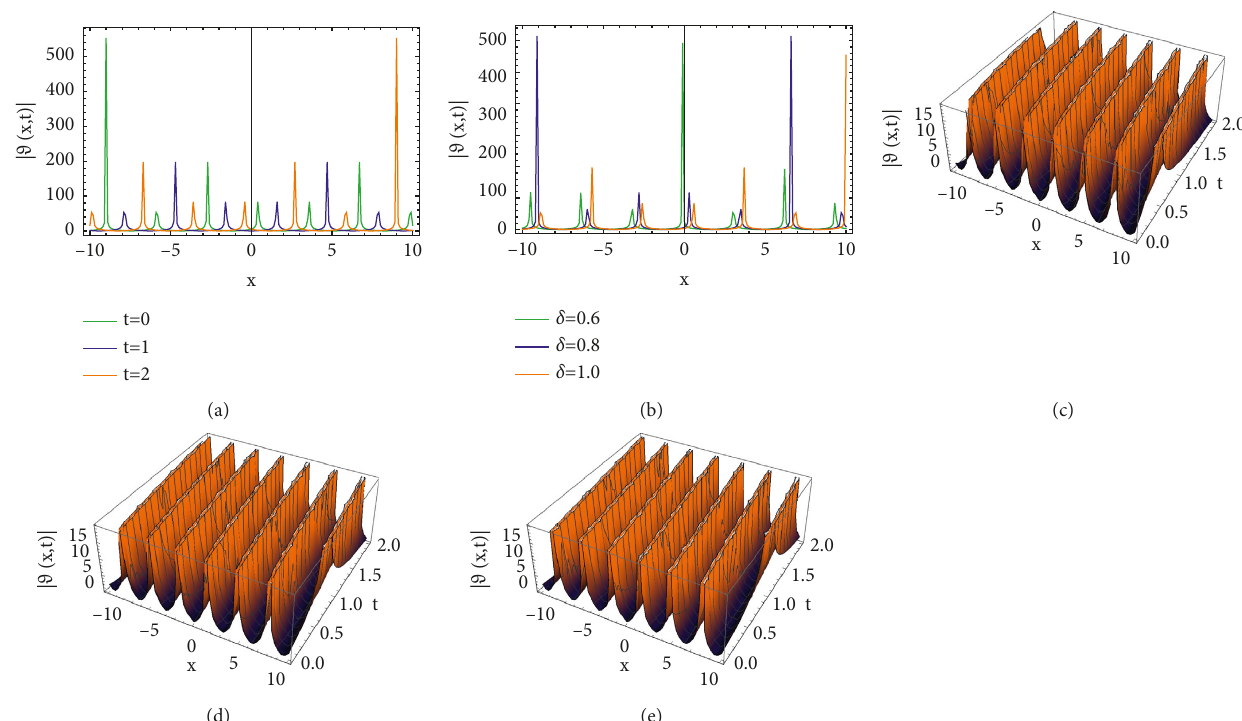
Figure 2: Periodic wave profile of ϑ